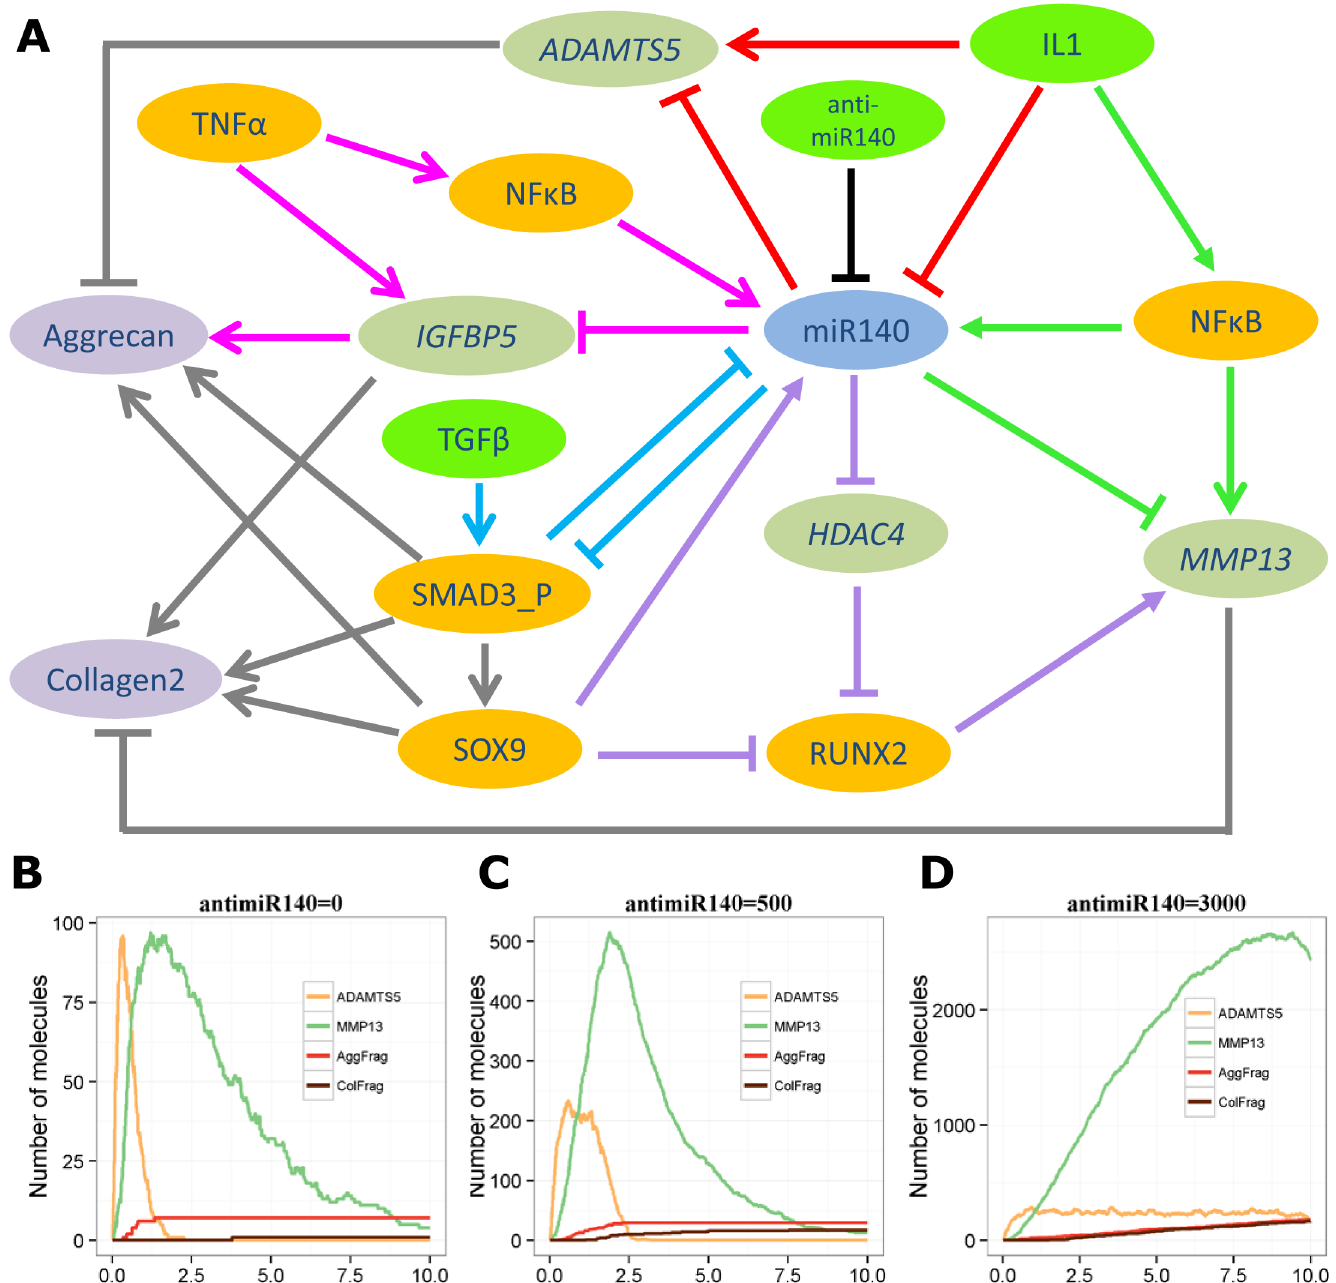
Fig 8. Integrated model:: Inhibition of miR-140. A , Diagramshowingmain components.Arrows indicate activation,blocked lines indicate inhibition.The red lines show coherent feedforward motif from miR-140/IL1/ADAMTS model; turquoise lines show postive feedbackmotif from the miR-140/TGF- β / SMAD3 model; green lines show the incoherent feedforward motif from the miR-140/IL1/MMP13 model; lilac lines show the incoherentfeedforward motif from the miR-140/SOX9 model; pink lines show the incoherent feedforward motif from the miR-140/IGF-1/TNF α model; dark grey lines indicate additional reactions for the combinedmodel. B - D , Output from the stochastic integratedmodel after a combinedstimulus of IL-1, TNF- α and TGF- β showing levels of ADAMTS-5 and MMP-13 protein, and the amount of Aggrecanand Collagen2 degradation(AggFrag and ColFrag, respectively). B, no inhibitionof miR- 140 (anti-miR140- = 0). C, moderate inhibitionof miR-140(anti-miR140 = 500); D, highinhibitionof miR-140(anti-miR140 = 3000).